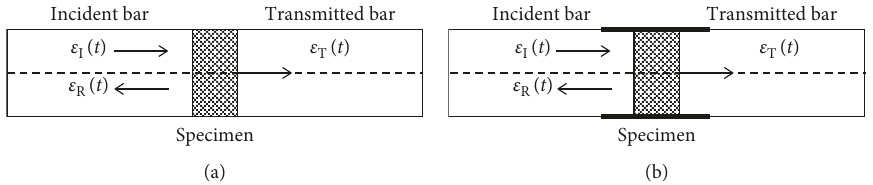
Figure 4: SHPB principle of ready-mixed concrete with different states. (a) Uniaxial load state. (b) Passive confining pressure